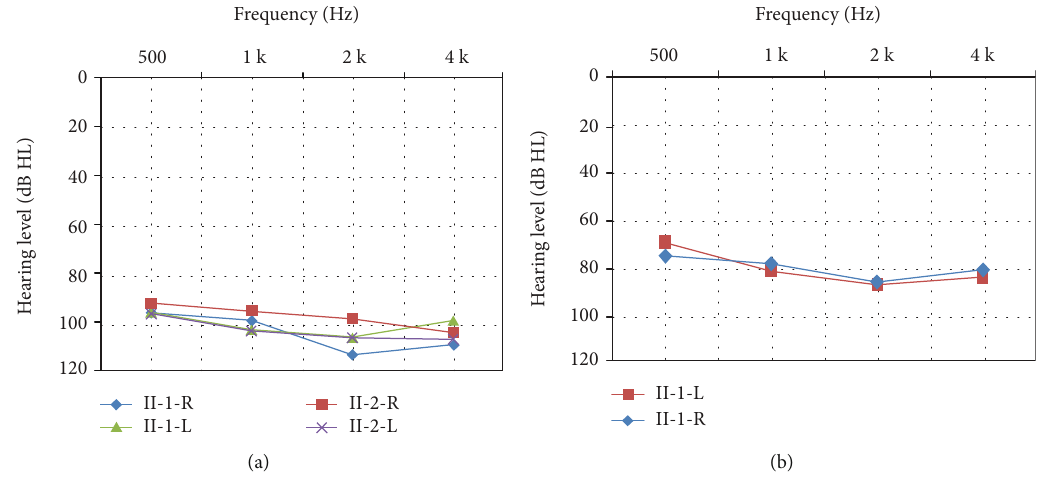
Figure 2: Audiograms of the a ff ected members of Family 1 (a) and Family 2